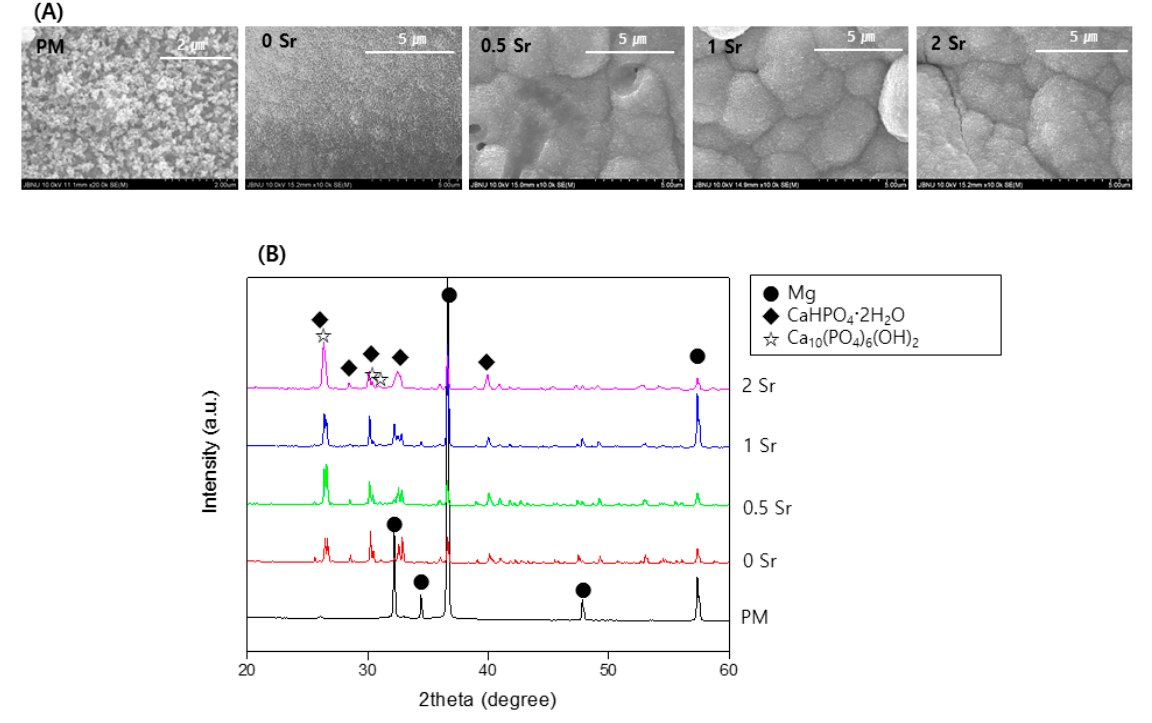
Figure 4. ( A ) FE-SEM images of the surface and ( B ) XRD patterns after immersion in Hanks’ solution for 14 days.